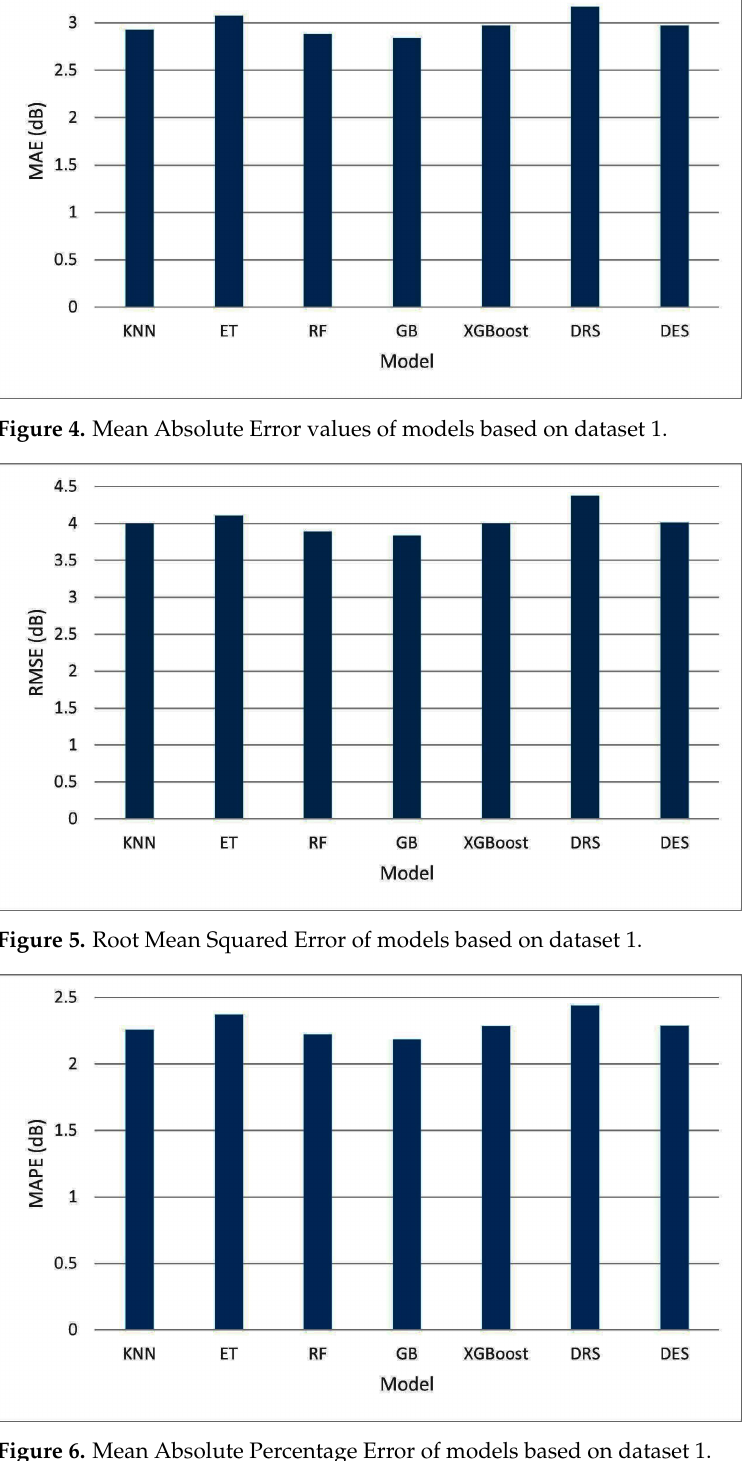
Figure 6. Mean Absolute Percentage Error of models based on dataset